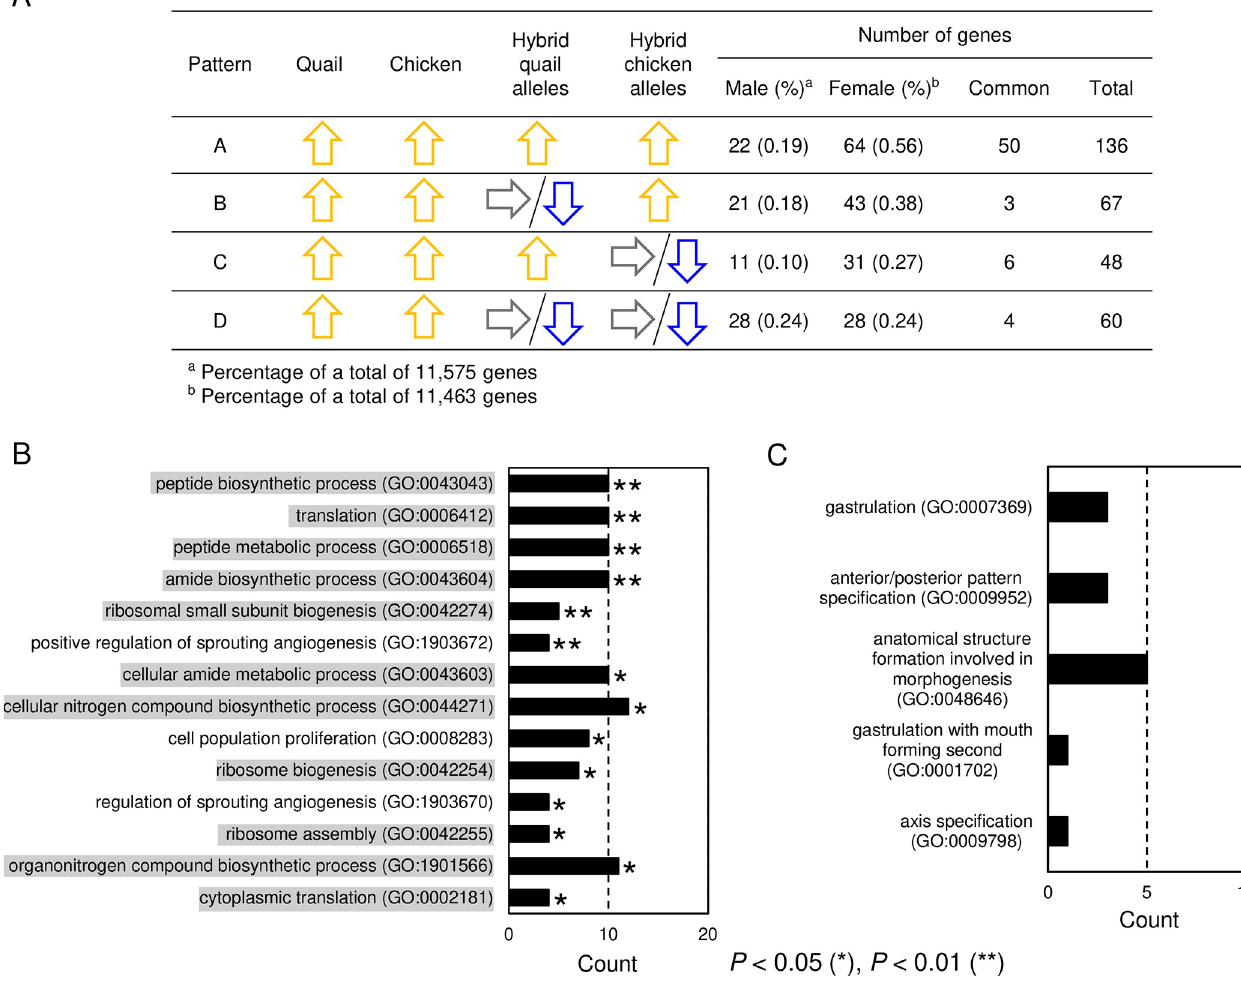
Fig 6. GO term enrichment analysis of genes whose expression was misregulated in the male and/or female hybrids. A. Number of genes whose expression was upregulated from the stage X to the stage XIII/XIV in male and/or female embryos of parental species. In pattern D, 60 genes showed no upregulation of their chicken- and quail-derived alleles in male and/or female hybrids. B. Overrepresented GO-BP terms and the number of genes that are associated with these terms. Eleven GO-BP terms that involve numerous ribosomal protein genes are indicated in gray. C. GO-BP terms related to primitive streak formation and the number of genes associated with these